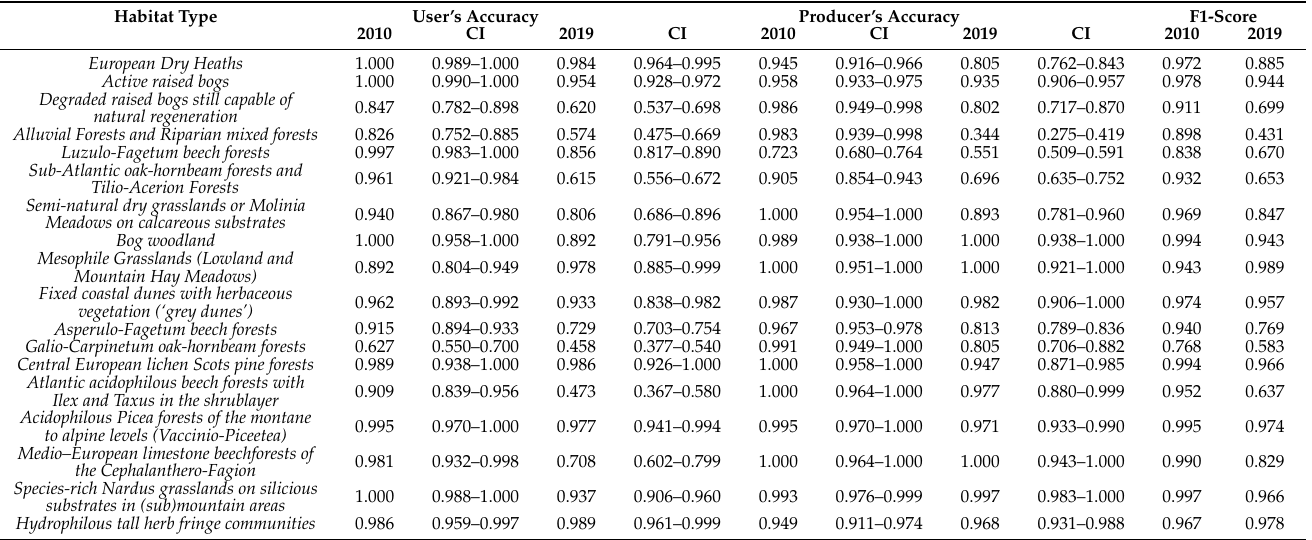
Table 3. Accuracy assessment (user’s accuracy, producer’s accuracy, and F1-score) of individual habitat types for both independent test years 2010 and 2019 for the ensemble prediction from all nine classification models for each year. CI columns show the associated 95% binomial proportion confidence intervals